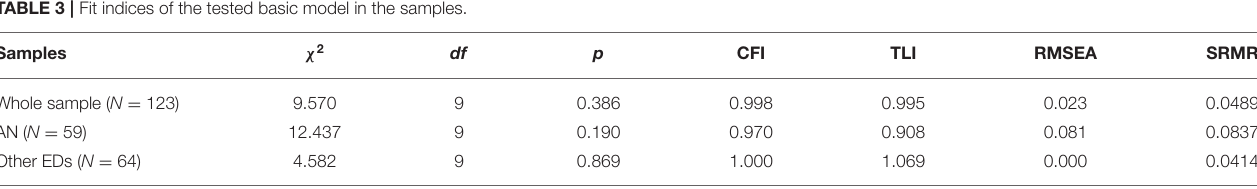
TABLE 3 | Fit indices of the tested basic model in the